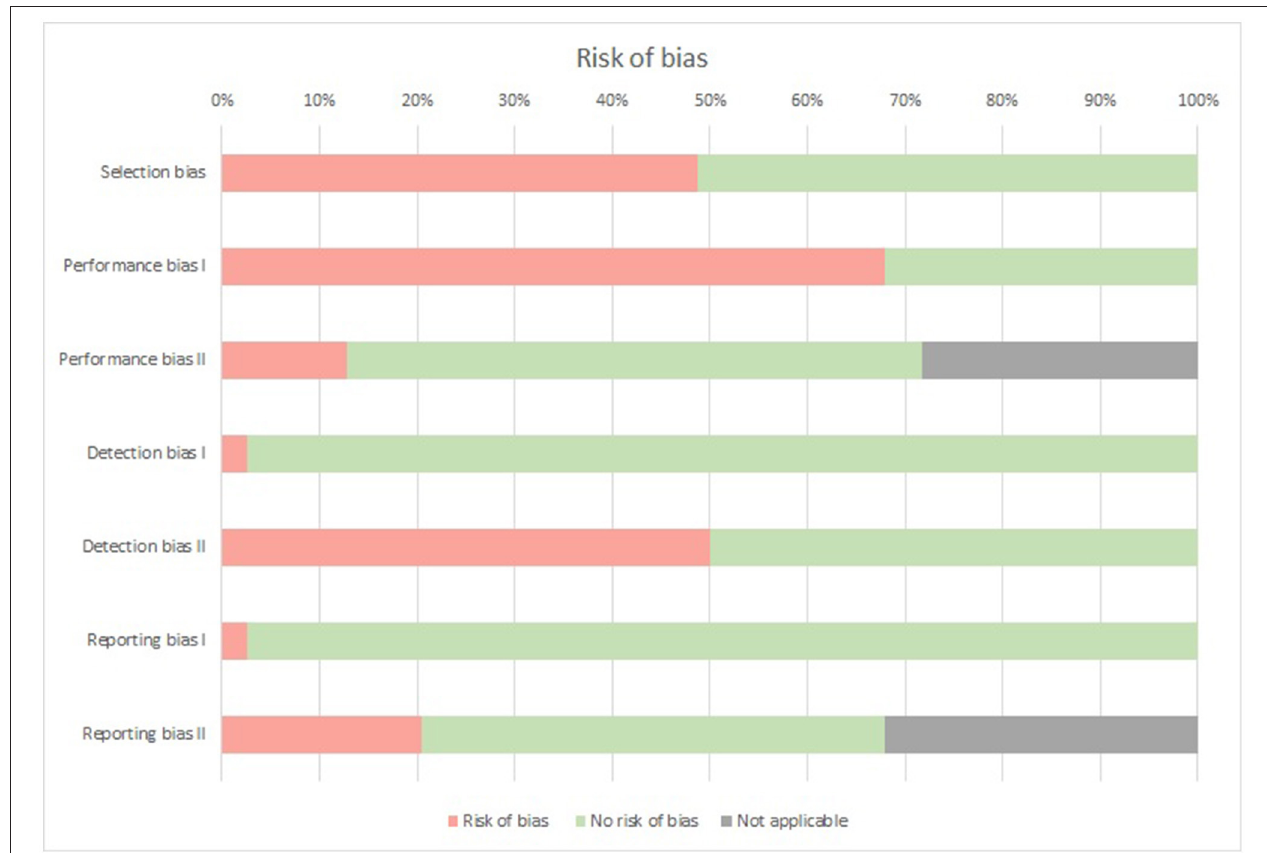
FIGURE 7 | Risk of bias